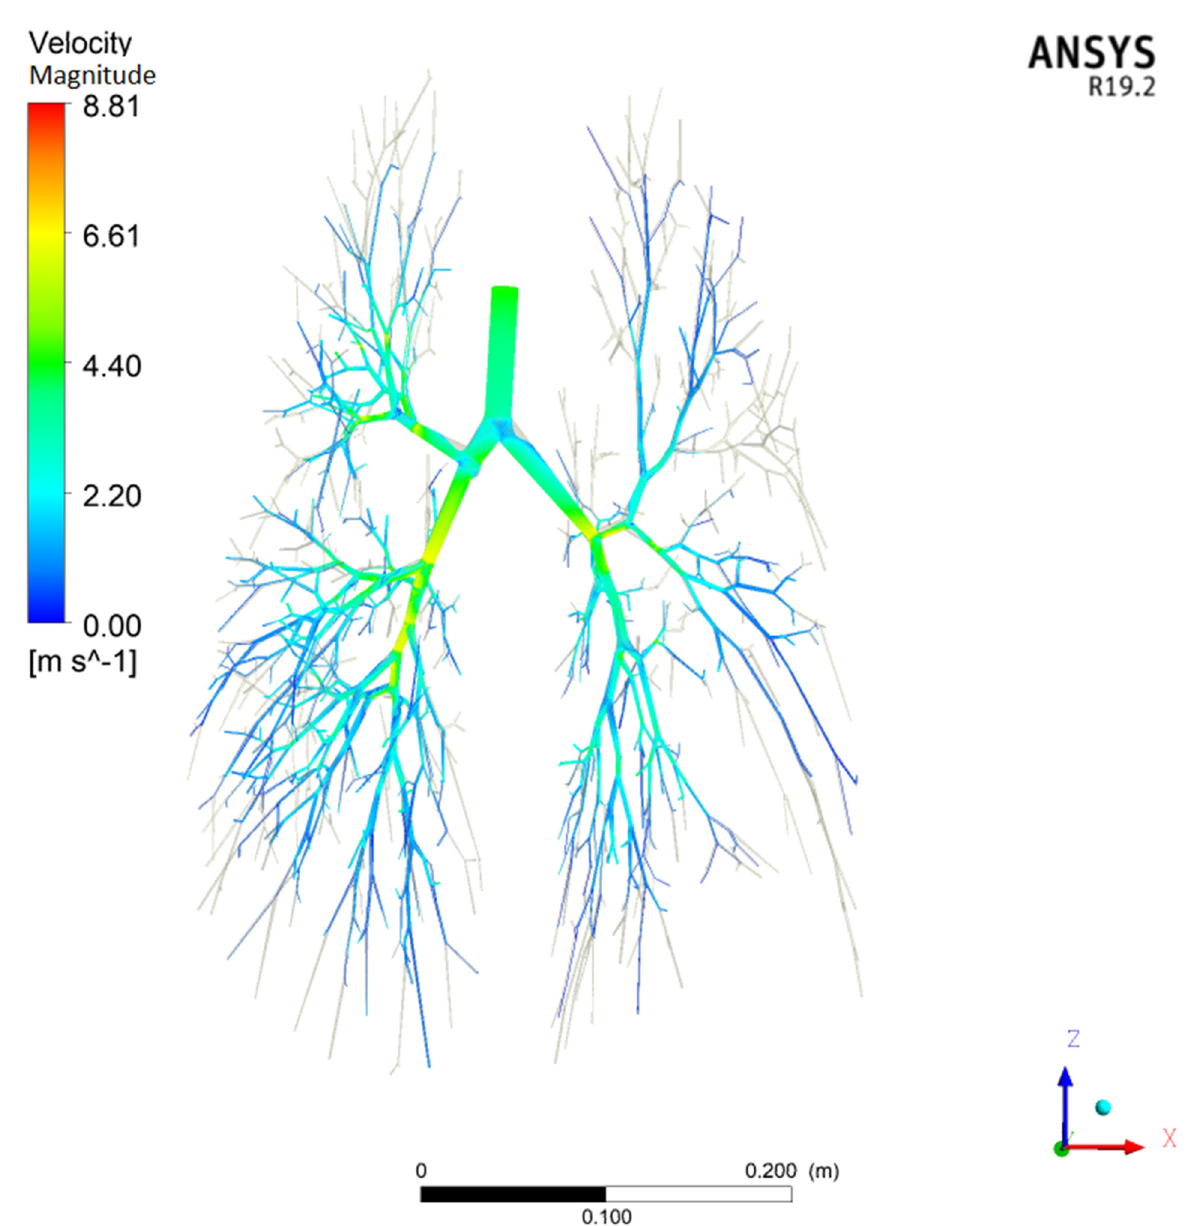
. Q g = 44 L/min and